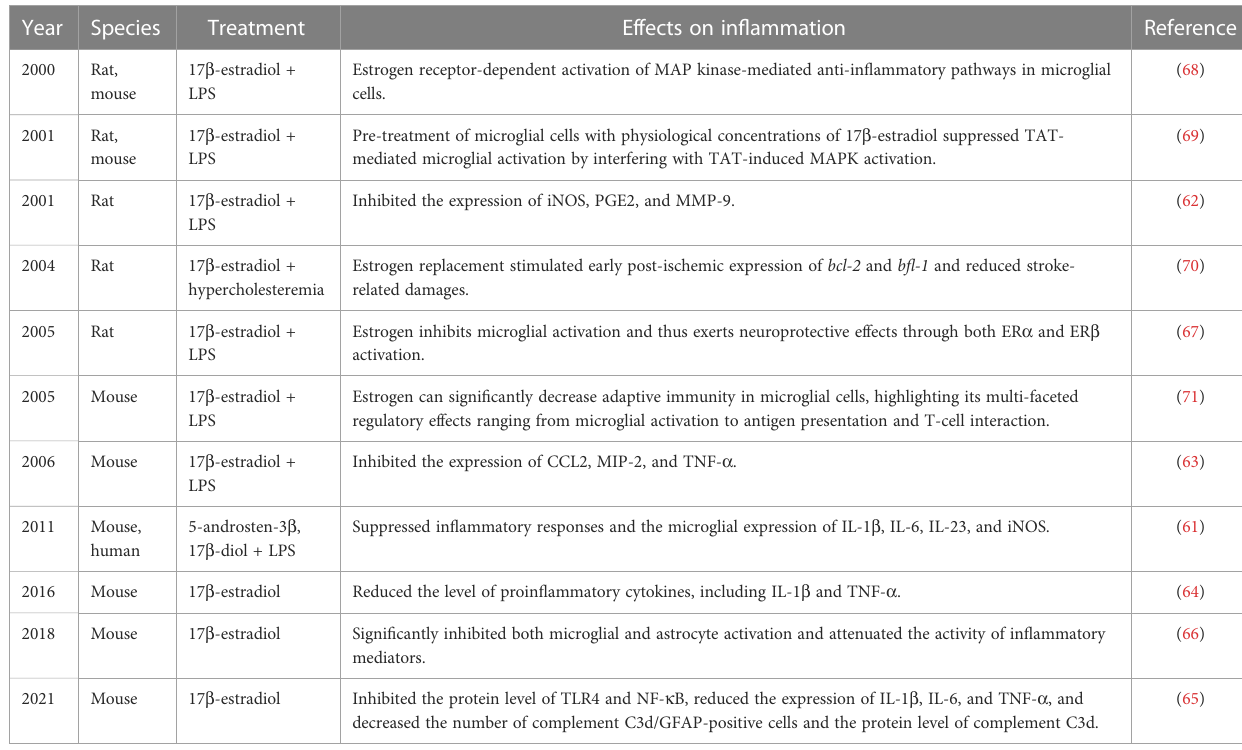
TABLE 1 Anti-in fl ammatory effects of estrogen on